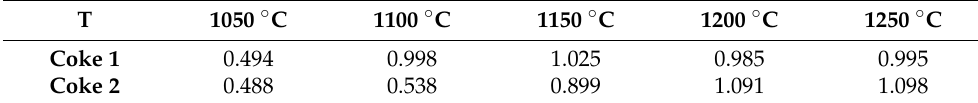
Table 7. Influencing factors of average weight loss rate in reaction time at each temperature point,